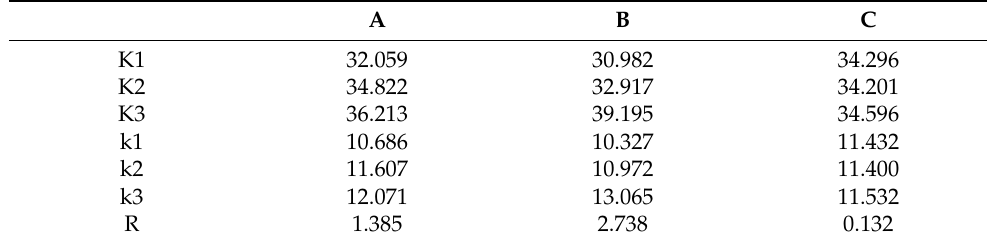
Table 4. Range analysis of crushing effect.